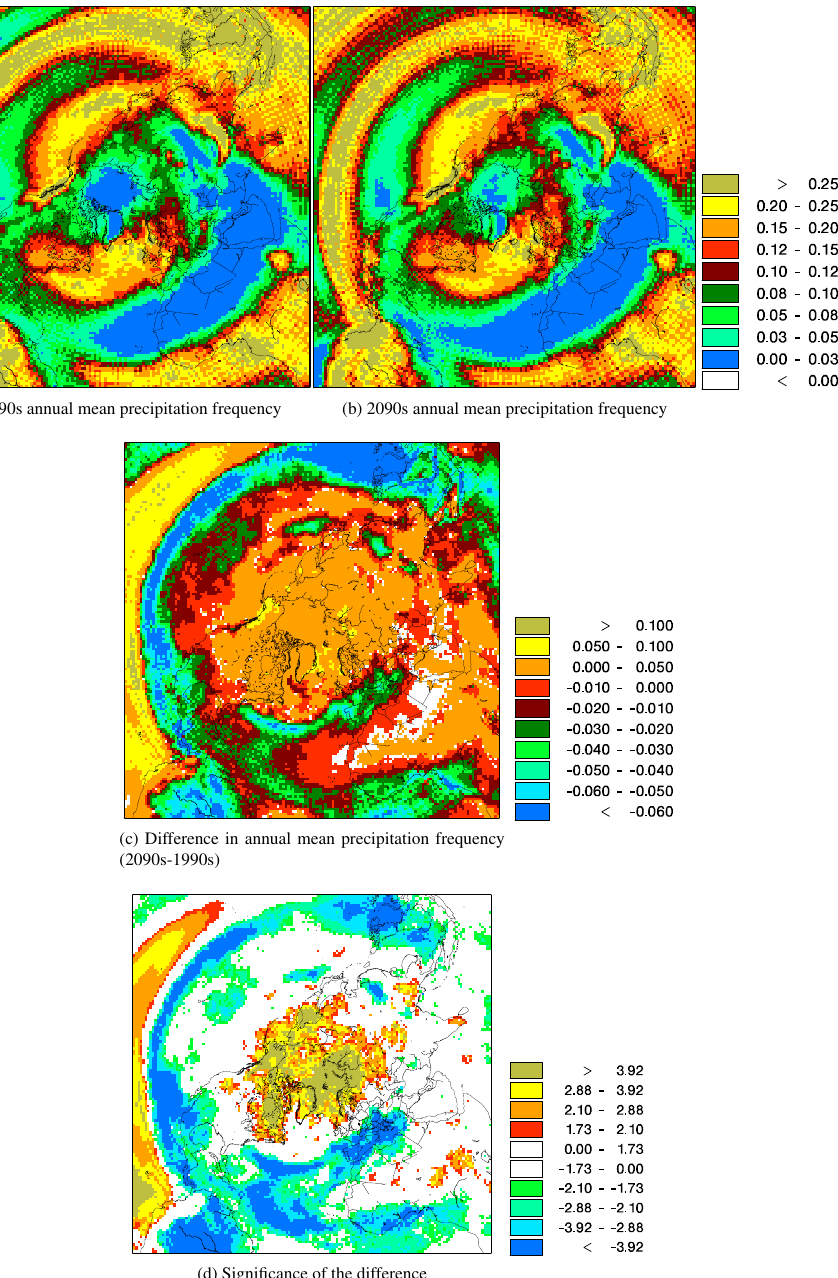
Fig. 1. Annual mean precipitation frequency: defined as a fraction between 0 and 1, the threshold value for precipitation in a given six-hour interval is 1mm. (a) shows the annual mean precipitation frequency during the 1990s decade and (b) during the 2090s decade. In (c) the difference between the 2090s and the 1990s is shown, and finally (d) illustrates the significance of the difference between the two decades, white colours indicate no significant change and the threshold value for significance is set to 10 %